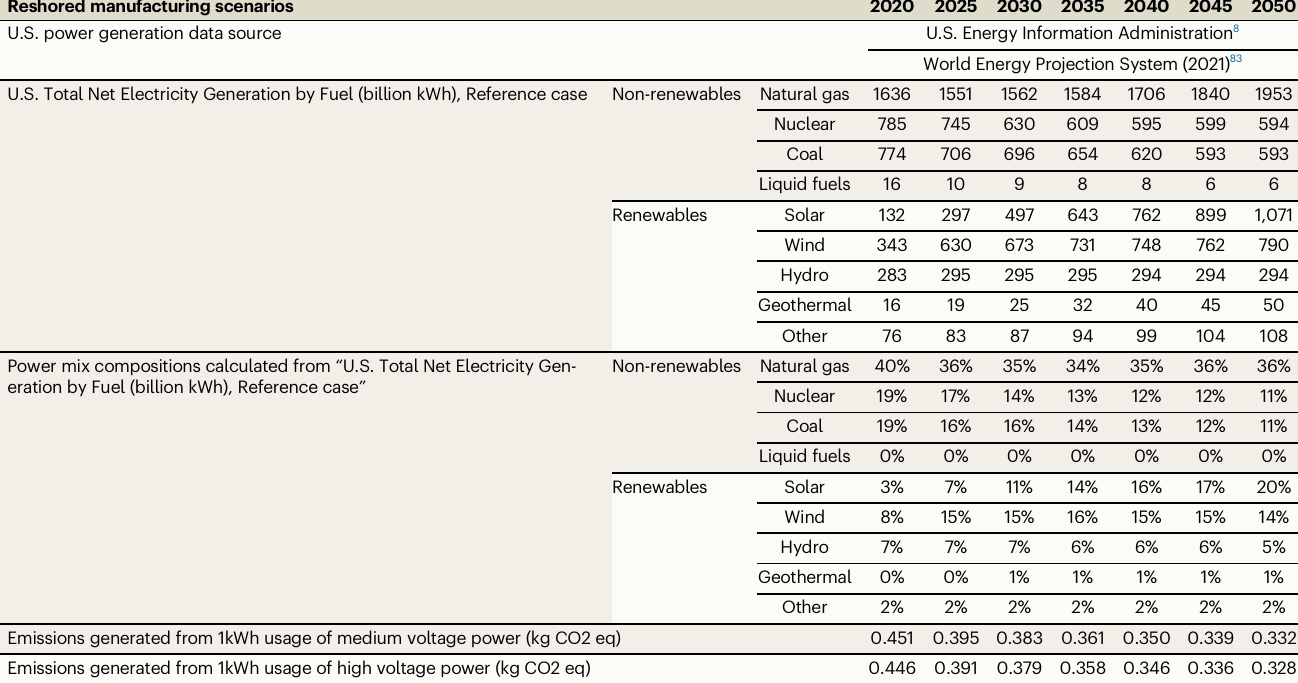
Table 3 | Energy structure of the U.S. from 2020 with projections to 2050, power generation data sources, and emissions generated from unit power usage Reshored manufacturing